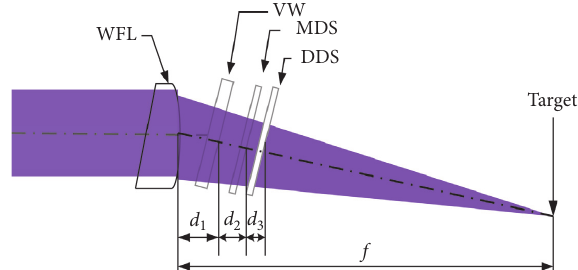
Figure 4: The model of high-order stray